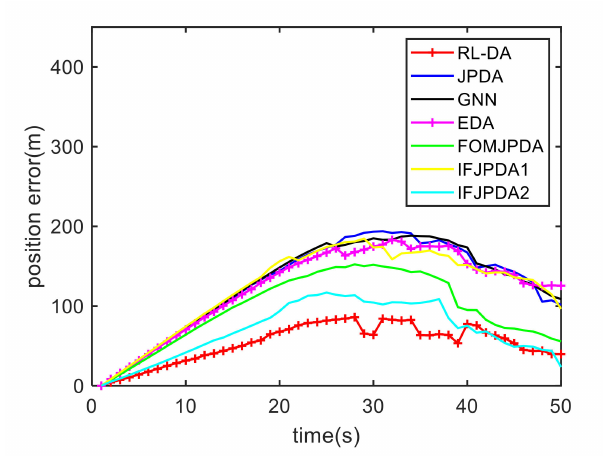
Figure 26. Comparison of the position errors for Target 2 in Case 2.